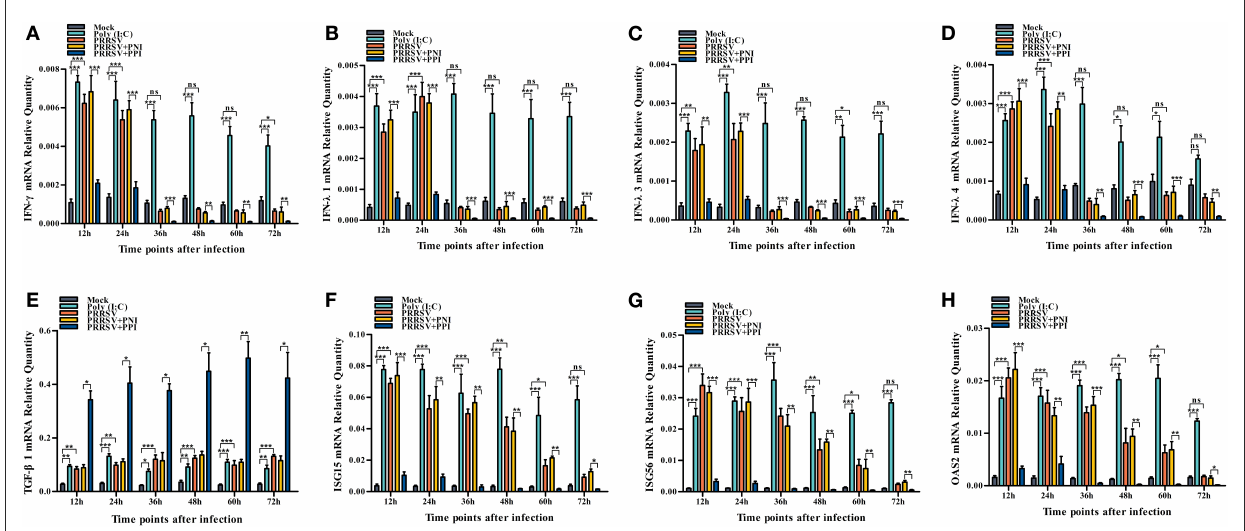
FIGURE2 The effect of PRRSV or PRRSV-ADE on mRNAs of the innate immune cytokines and antiviral protein genes in PAMs. The mRNAs of the innate immune cytokines and antiviral protein genes in treated PAM cells were evaluated using relative quantitative RT-PCR. (A) IFN- γ mRNA, (B) IFN- λ 1 mRNA, (C) IFN- λ 3 mRNA, (D) IFN- λ 4 mRNA, (E) TGF- β 1 mRNA, (F) ISG15 mRNA, (G) ISG56 mRNA, and (H) OSA2 mRNA. The bars indicate the relative expression levels of mRNAs of the innate immune cytokines or antiviral protein genes. The error bars indicate the SEM from three independent experiments.